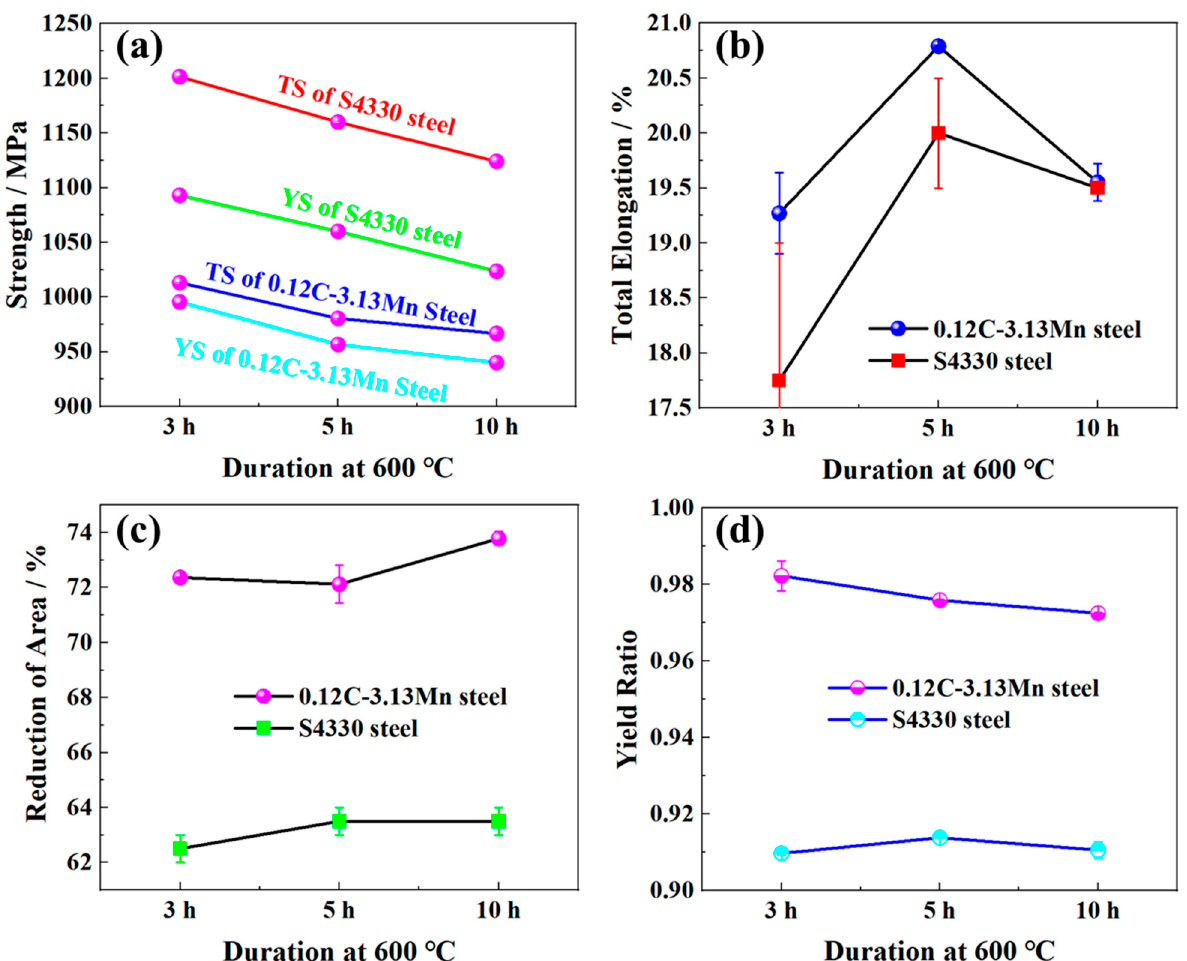
Figure 3. Mechanical properties of 0.12C-3.13Mn steel and S4330 steel: ( a ) yield strength and tensile strength; ( b ) total elongation; ( c ) reduction of area; ( d ) yield ratio.